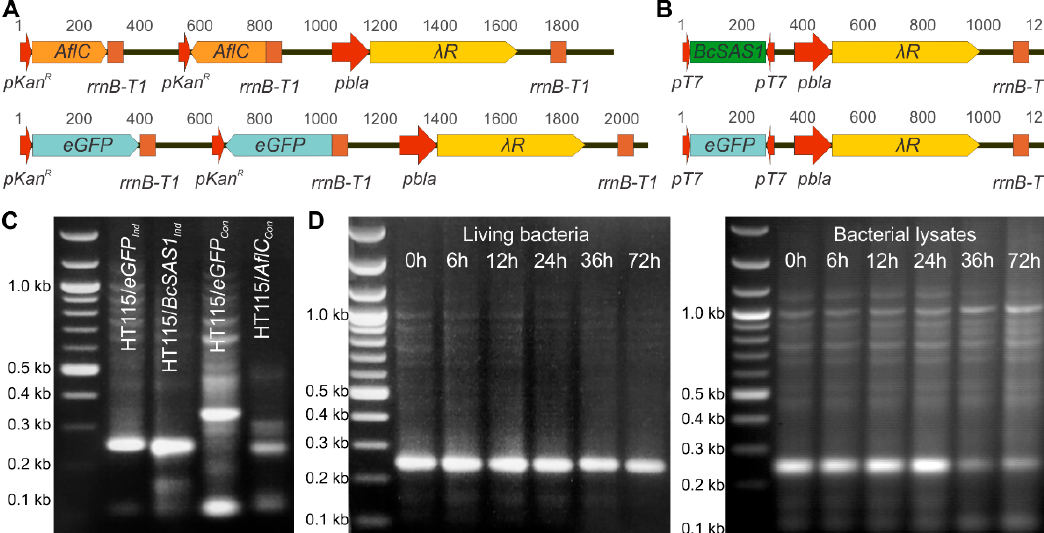
Figure 1. Bacteria can be genetically engineered to produce dsRNAs against target genes in fungi. ( A , B ) Schematic representation of the two transcriptional configurations used for the synthesis of dsRNAs against AflC in A. flavus and BcSAS1 in B. cinerea , respectively as well as for the synthesis of dsRNA against the enhanced green fluorescent protein (eGFP). The full plasmid maps are shown in Figure S1. pKan R : kanamycin resistance gene; rrnB-T1: transcriptional terminator T1 of the rrnB gene; pT7 : T7 RNA polymerase promoter; pbla : promoter of the β -lactamase gene; λ R: phage lambda endolysin gene; AflC: Type I polyketide synthase (pksA) in A. flavus ; BcSAS1 : Rab family member of small GTPases; eGFP: enhanced green fluorescent protein. ( C ) Agarose gel electrophoresis of dsRNAs extracted from the autolyzed HT115/ AflC Con , HT115/ BcSAS1 Ind , HT115/ eGFP Con , and HT115/ eGFP Ind strains. Production of dsRNAs in the HT115/ BcSAS1 Ind and HT115/ eGFP Ind strains requires the addition of IPTG in the culture medium of the bacteria, which was added at a final concentration of 1.0 mM when cultures reached an OD 600 ≈ 0.8. ( D ) Stability over time of the dsRNAs produced by the HT115/ BcSAS1 Ind strain over time. Stability was examined both in living bacteria cells (left-hand side image) and their whole-cell autolysates (right-hand side image). An equal volume of 5 µ L was loaded in the wells of the agarose